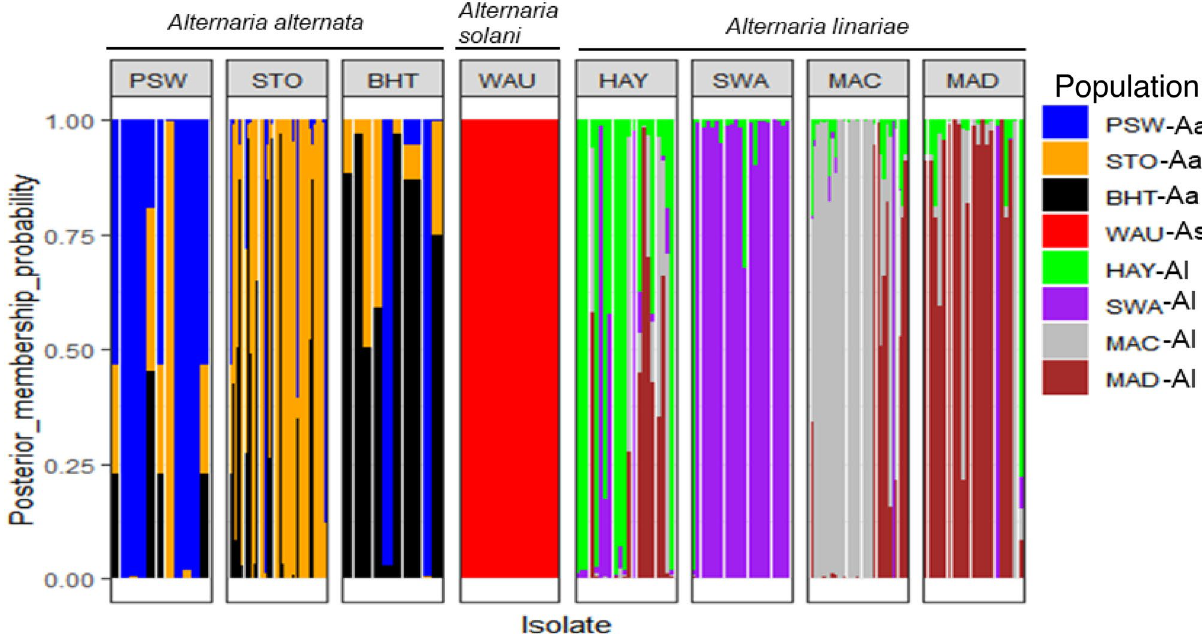
Figure 5. A bar plot showing the population membership probability assignments in eight geographic populations of three Alternaria species collected from tomato and potato in North Carolina and Wisconsin using 220 single nucleotide polymorphisms (SNPs) from 10 microsatellite loci. Bars of the same colour represent the likelihood of the same genetic cluster based on analysis. Bars of mixed colours are admixture